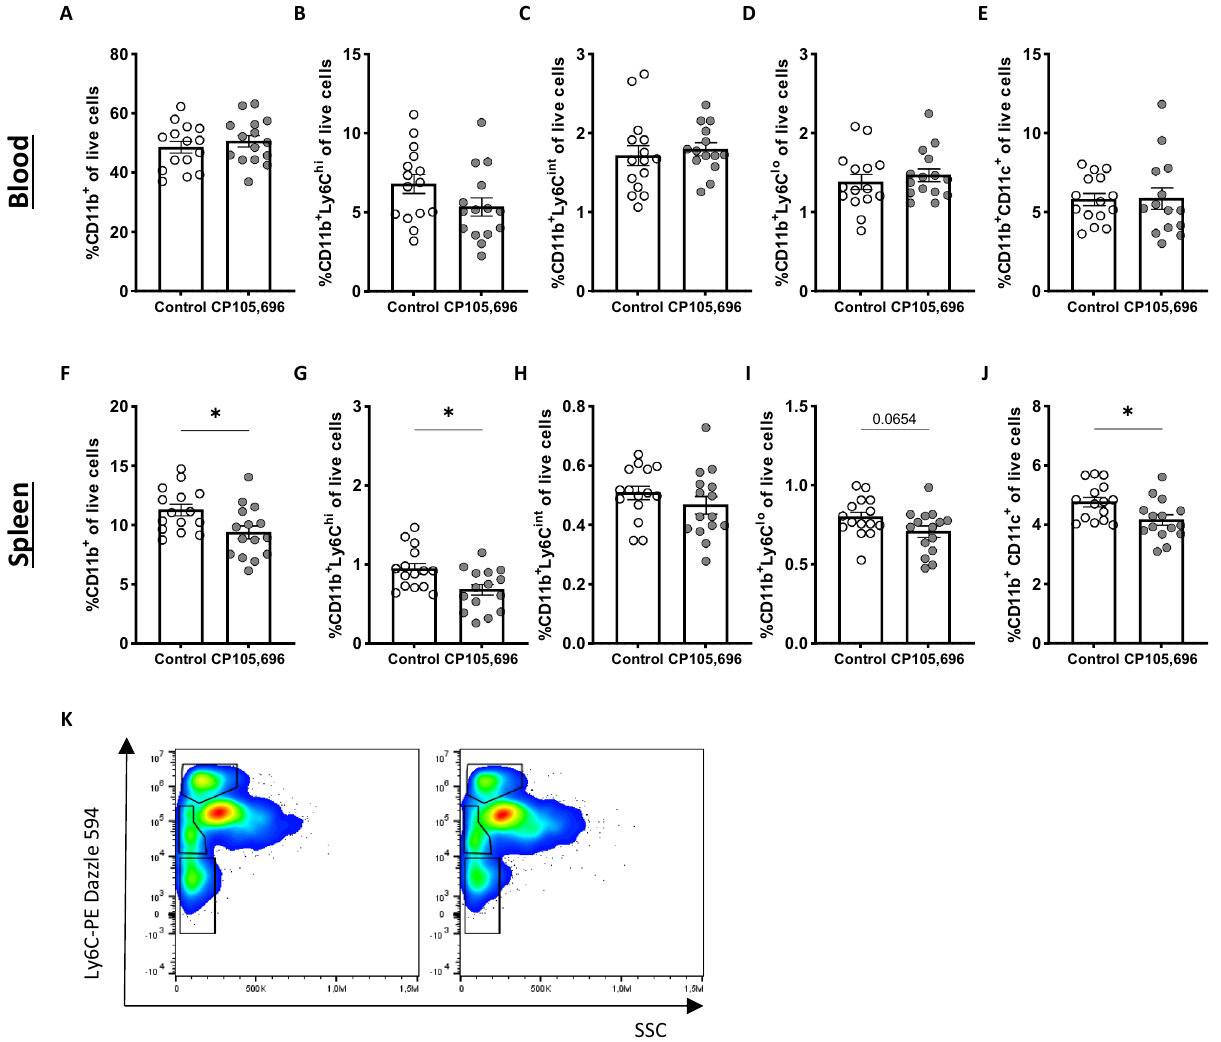
Figure 3. Myeloid cells significantly decreased with BLT1-antagonism in the spleen. Upon sacrifice, blood and spleen were collected and processed to obtain a single cell suspension for flow cytometry analysis. In the blood, the percentage of ( A ) CD11b + myeloid cells, ( B ) Ly6C hi monocytes, ( C ) Ly6C int monocytes, ( D ) Ly6C lo monocytes and ( E ) CD11b + CD11c + dendritic cells was not different between the CP105,696 treated and the control group. In the spleen, a significant reduction in the percentage of ( F ) CD11b + myeloid cell content was found with CP105,696 treatment. Specifically, BLT1-antagonism resulted in a decrease in ( G ) the percentage of CD11b + Ly6C hi monocytes, no difference in ( H ) the percentage of CD11b + Ly6C int monocytes and ( I ) a trend towards a decrease in the percentage of CD11b + Ly6C lo monocytes. ( J ) Furthermore, we observed a significant decrease in the percentage of CD11b + CD11c + dendritic cells. ( K ) Representative Flow Cytometry plot of monocytes in the spleen, left: control, right: CP105,696. n = 14–15 per group. Data represent mean ± SEM. * p <